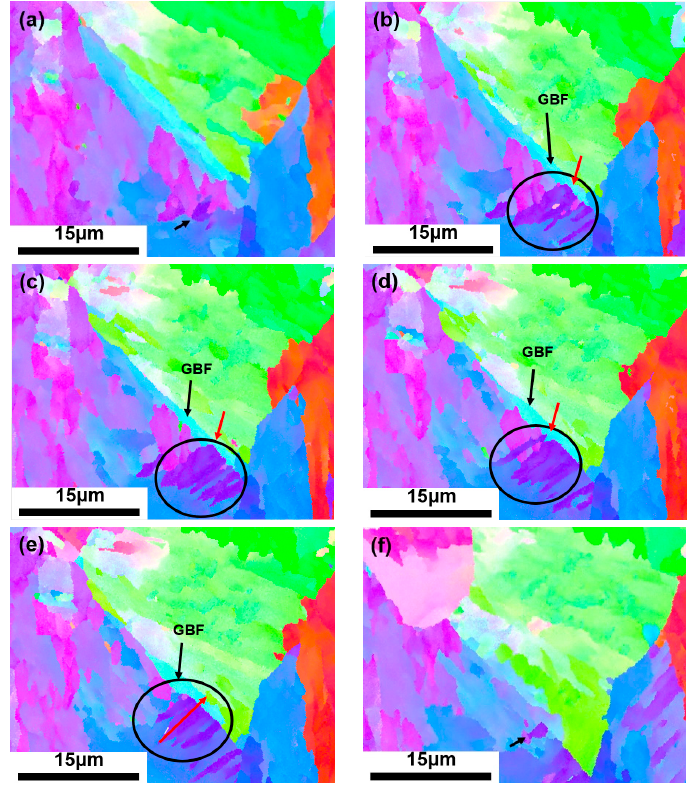
Figure 9. Grain orientation of secondary Widmanstätten cutting process. ( a ) 51st layer, ( b ) 59th layer, ( c ) 62nd layer, ( d ) 68th layer, ( e ) 72nd layer, ( f ) 93rd layer. Figure 10 illustrates the accumulated misorientation of the red line from bottom to top of the line in Figure 9e. There is an abrupt change in orientation of 2°–3° near the interface between the bottom of the secondary Widmanstätten sideplates and the GB fer- rite. Cheng Lin et al. [14] claimed that this difference was the direct evidence of nucleation excitation of the secondary Widmanstätten sideplates on GB ferrite.